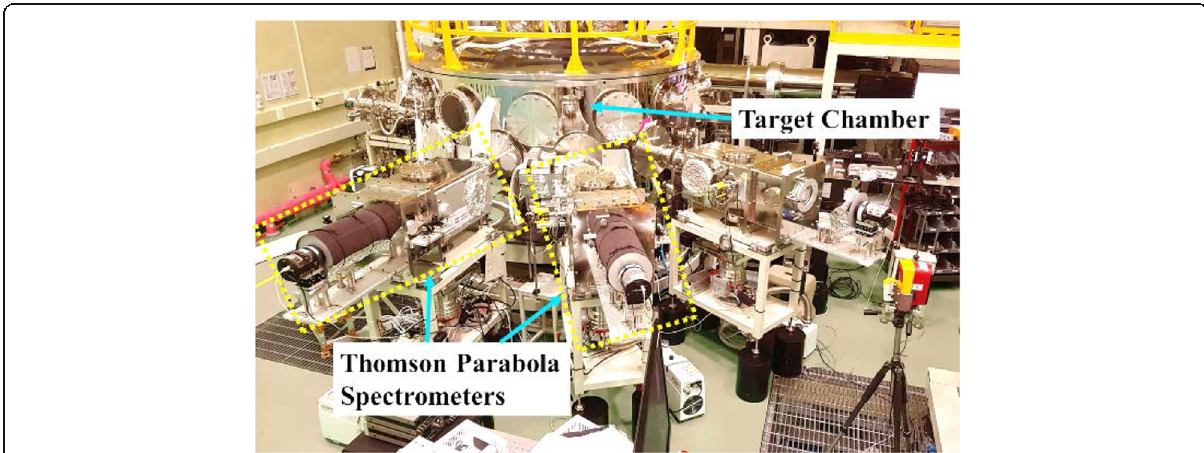
Fig. 20 Target chamber for ion acceleration experiments at the CoReLS. The Thomson parabola spectrometers used for the detection of proton spectra are